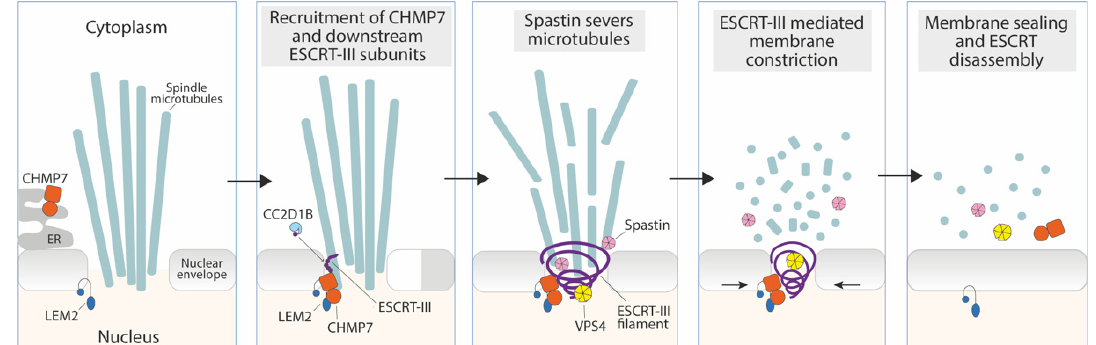
Figure 2. ESCRT-mediated sealing of the nuclear envelope during mitotic exit. In late anaphase, the inner nuclear membrane protein LEM2 recruits and activates CHMP7 to holes in the reforming nuclear envelope, which drives ESCRT-III polymerization. Premature ESCRT-III recruitment to the nuclear membrane is prevented by CC2D1B, which dissociates prior to ESCRT recruitment. Spastin recruitment by ESCRT-III triggers severing of mitotic spindle microtubules, while VPS4 remodeling of ESCRT-III filaments promotes membrane constriction and sealing of the nuclear envelope.